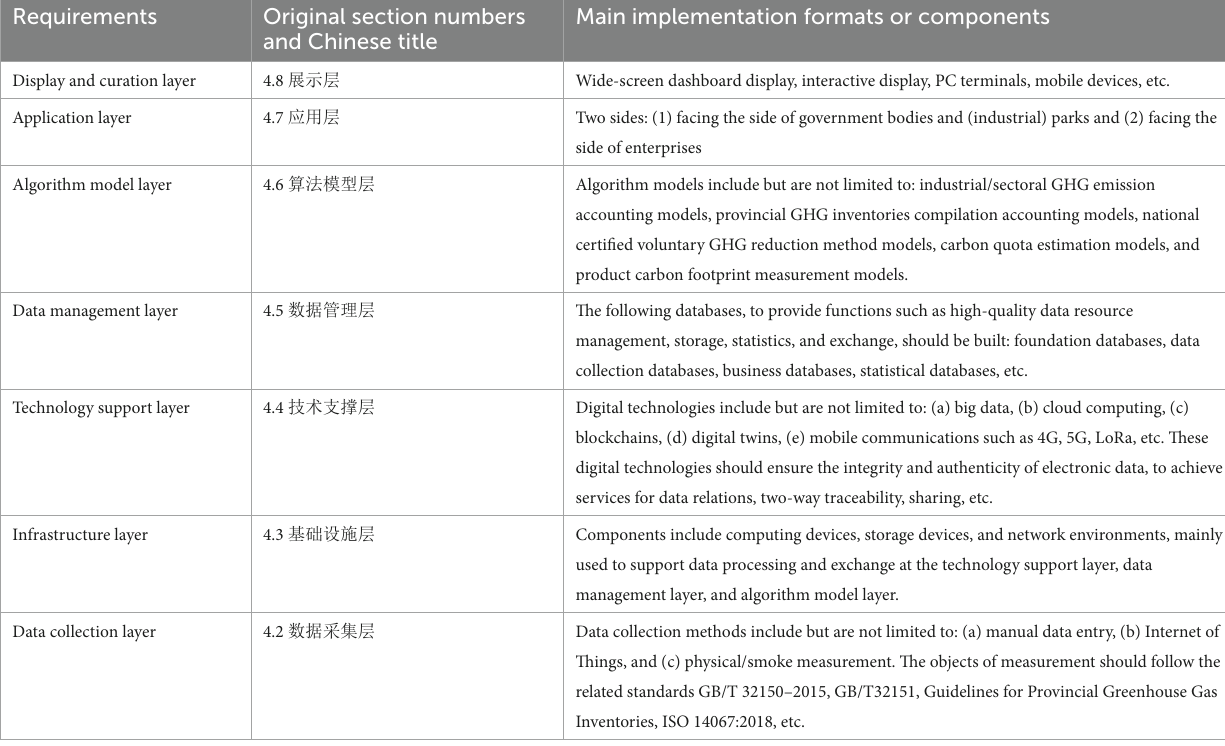
TABLE 1 Architectural requirements of China’s “Carbon Peak Carbon Neutral Management and Service